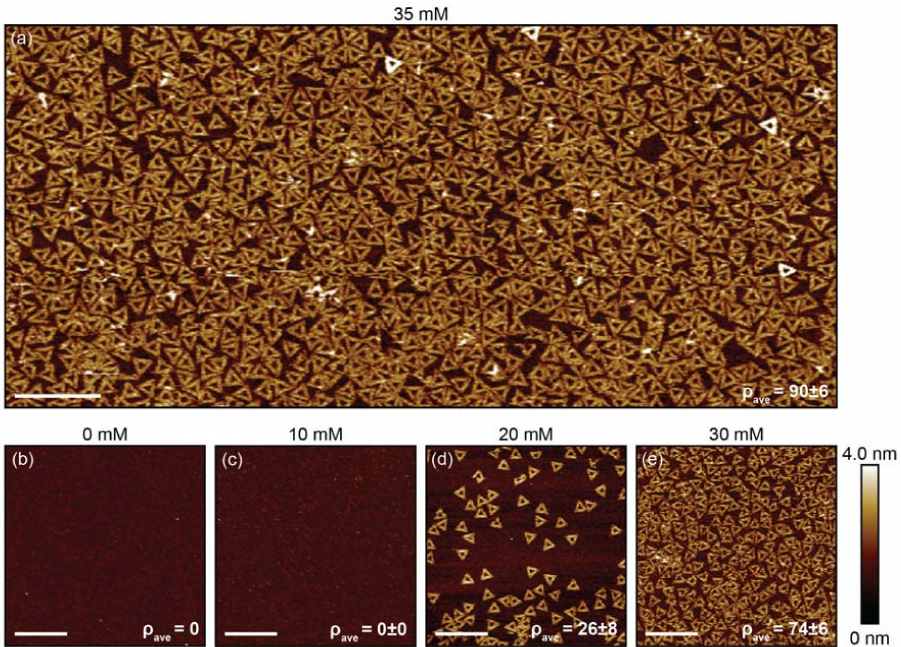
Figure 2. Atomic force microscopy (AFM) images of DNA origami triangles adsorbed onto boron-implanted silicon substrates. Prior to the DNA origami triangle deposition, the samples were cleaned with Piranha + hydrofluoric acid (HF). For all conditions, the deposition buffers were 10 mM bis-tris hydrochloric acid (HCl) with a pH of 6.6 and the deposition incubation time was ~24 h. The MgCl 2 concentration ([MgCl 2 ]) for (a) was 35 mM. The average surface density increased from 0 to 90 ± 6/ µ m 2 as the [MgCl 2 ] increased from 0 to 35 mM. Scale bars are 500